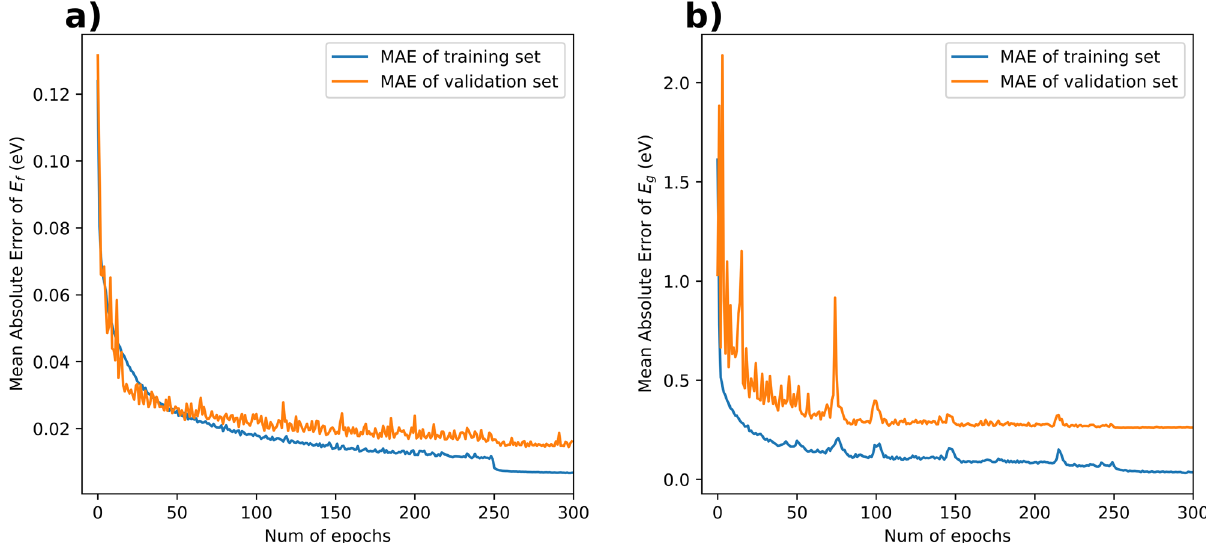
Fig. 9 The plot of learning history on full OQMD database. a Red line shows the MAE of training set in the learning process of 449,506 E f training data. Blue line shows the MAE of validation set in the training process of 56,188 E f validation data. b The learning history of 24,296 E g training data and 3,036 E g validation